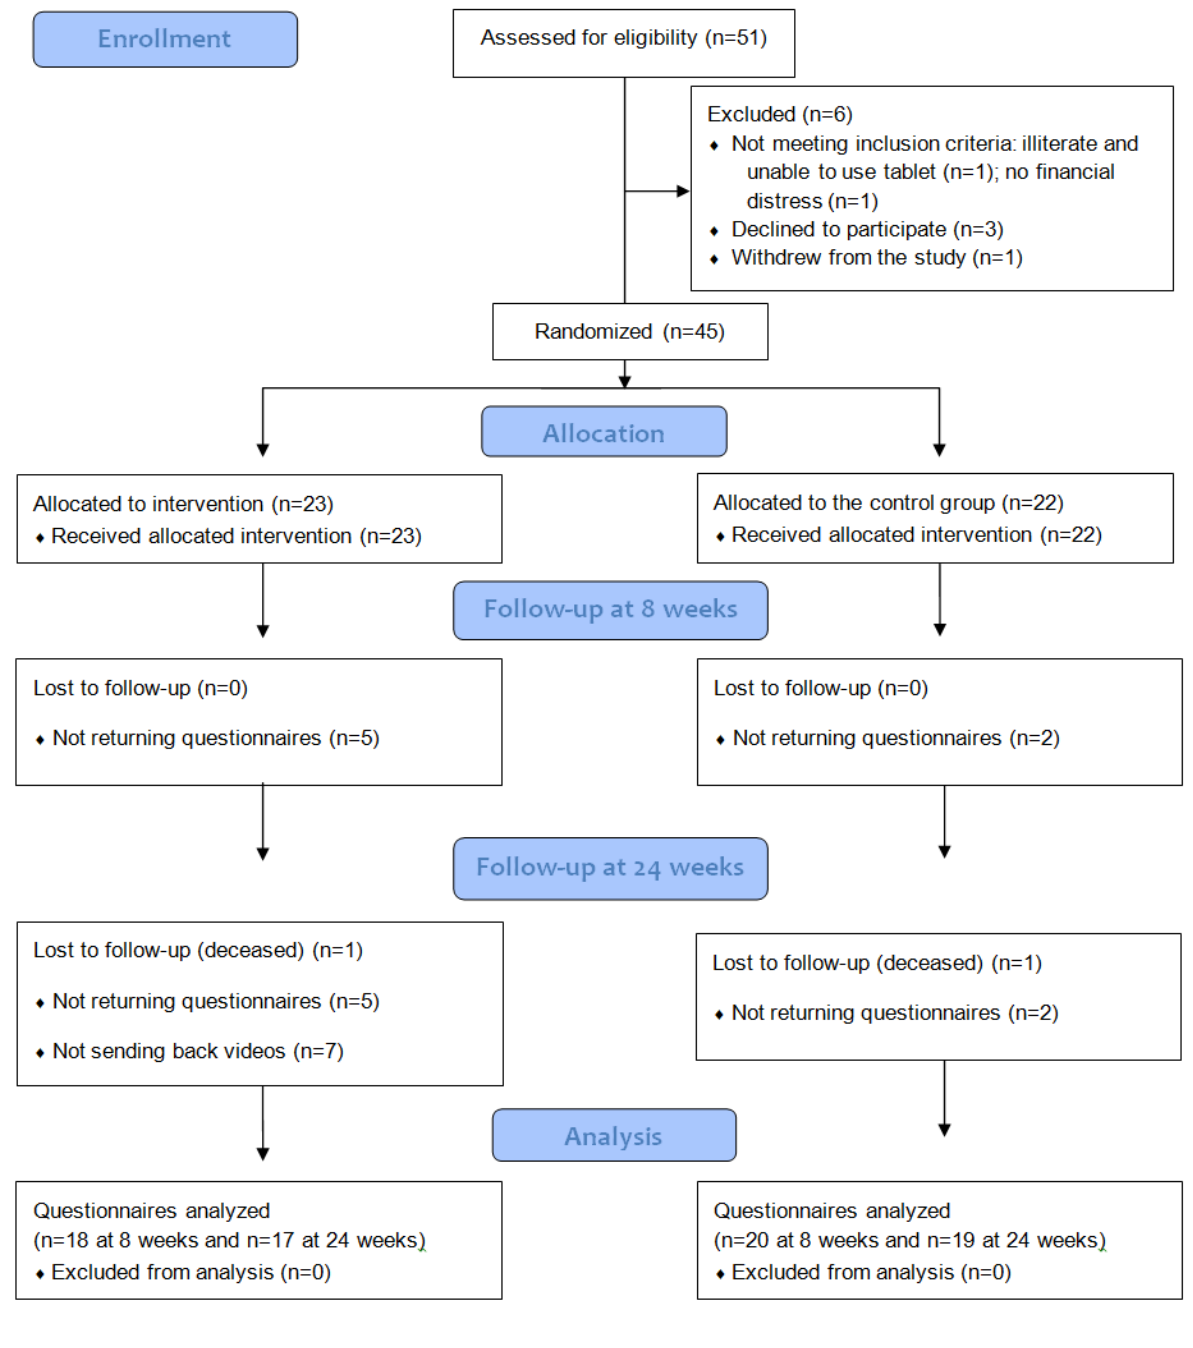
Figure 2. The CONSORT (Consolidated Standards of Reporting Trials)